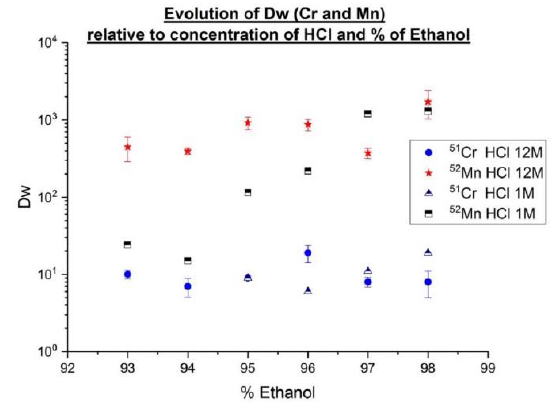
Figure 17. D w of Mn and Cr.